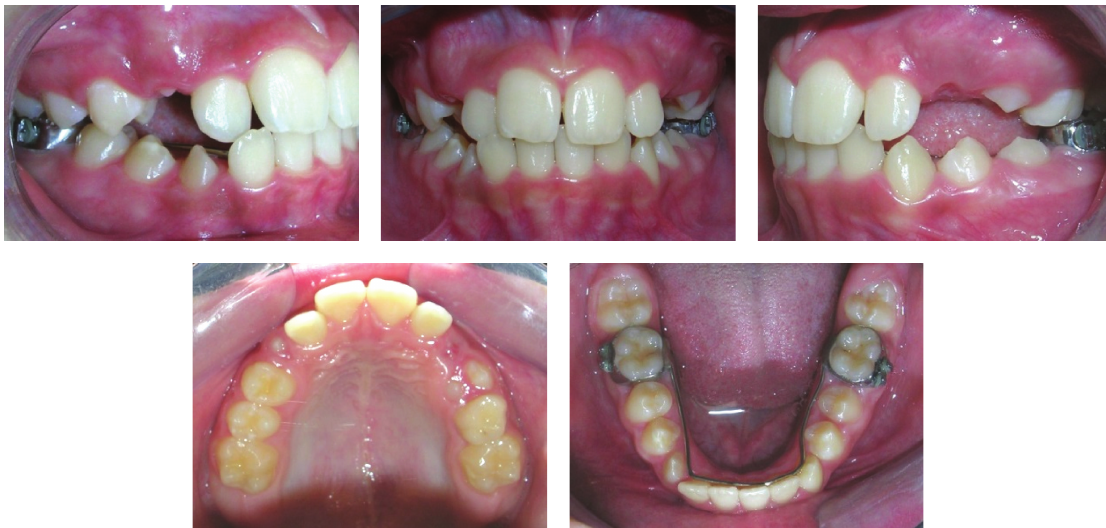
Figure 3: Lingual holding arch and the maintenance of the E-space.